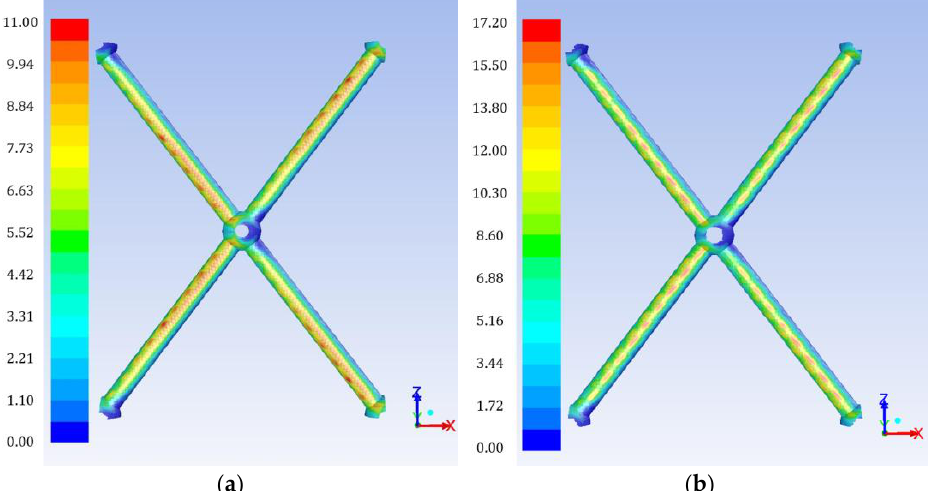
Figure 3. Instantaneous spatial distribution of the shear stress on the surface of the novel spacer filaments for two gap reduction values; ( a ) h/D = 0.075, ( b ) h/D = 0.10.